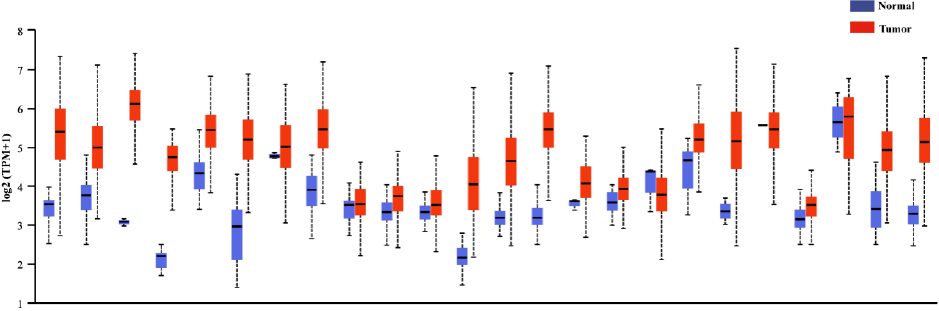
Figure 4. Expression of FEN1 across TCGA cancers (with tumor and normal samples).